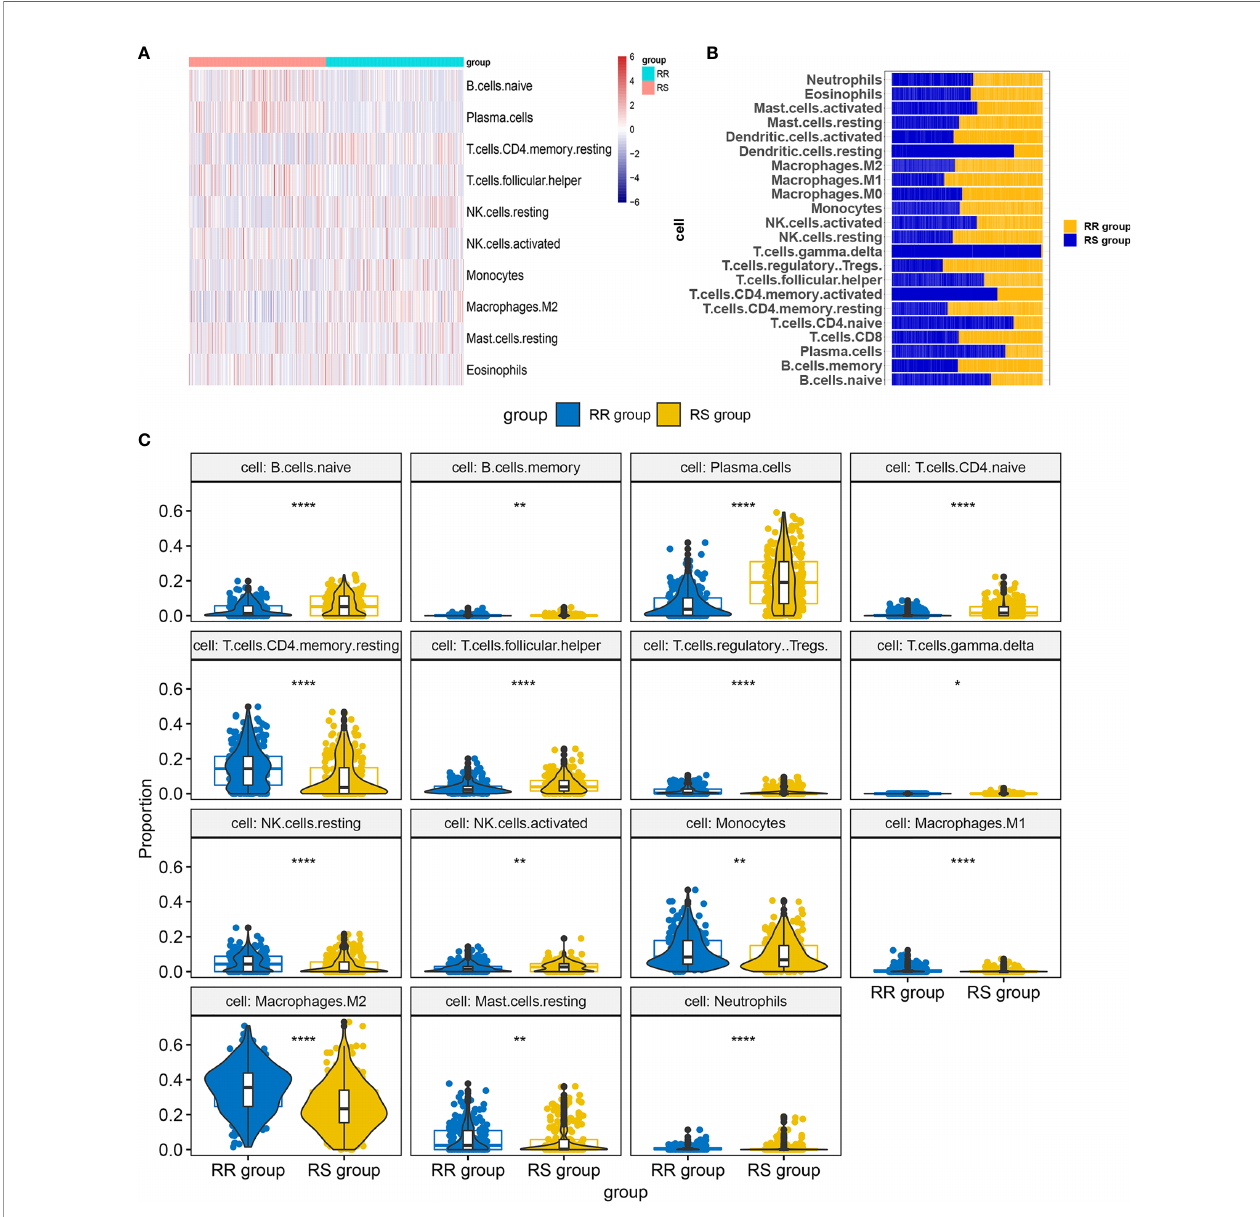
FIGURE 7 | In fi ltration levels for RS and RR group. (A) Heat map of in fi ltration cells in RS and RR group. (B) Bar graphs of mean percentage of immune cells in RS and RR group. (C) Violin plots illustrating the relative proportions of the 15 TIICs exhibiting signi fi cantly different in fi ltrating degree in RS and RR group. RR, radioresistant group. RS, radiosensitive group. *p < 0.05, **p < 0.01, ***p < 0.001, ****p <